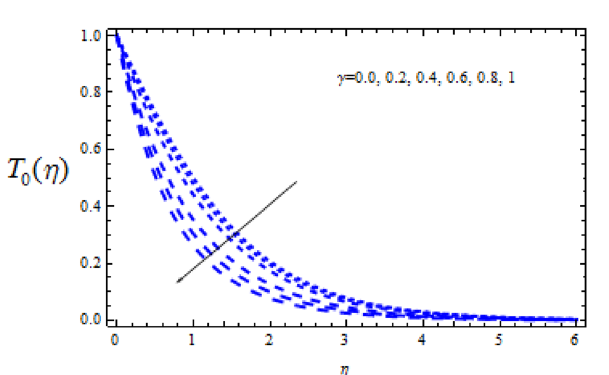
Figure 18. Consequence of ϒ on T 0 (η) .